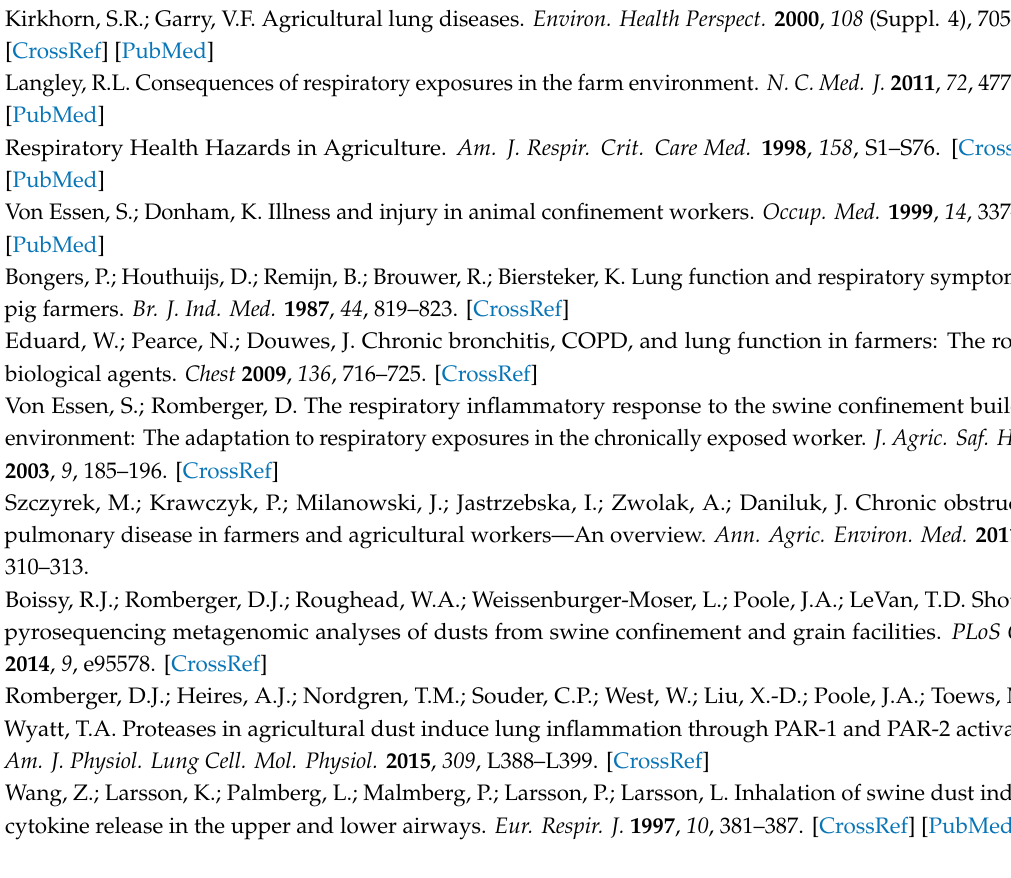
Figure S1: Initial and Final weights of mice fed a control diet or high DHA diet for 4